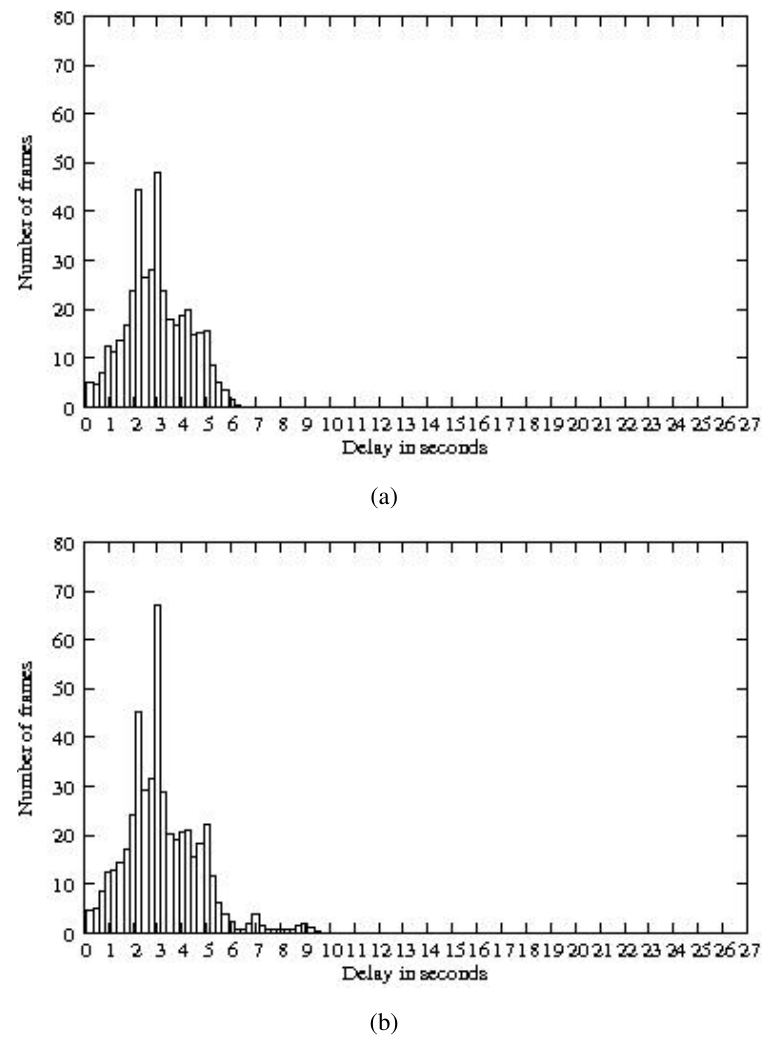
Figure 17. End-to-end delays with heterogeneous traffic with buffers of: (a) 20 messages; (b) 60